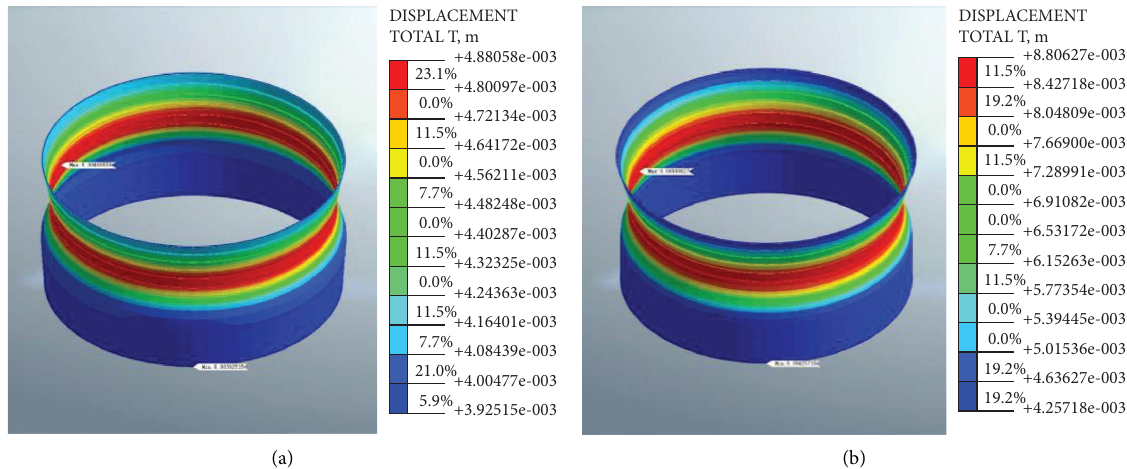
Figure 25: Working condition 7 wall deformation (a) without pore water pressure and (b) with pore water pressure